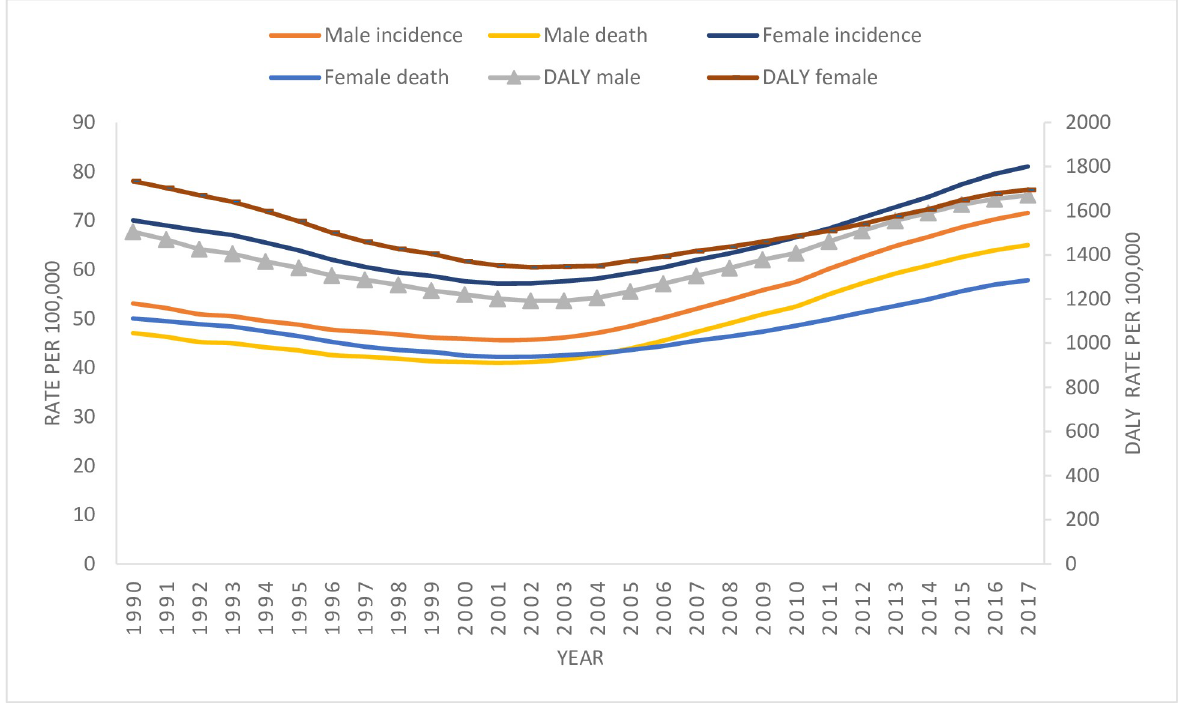
Fig 1. Trend of cancer by crude incidence rate, mortality rate and DALY in Nepal,